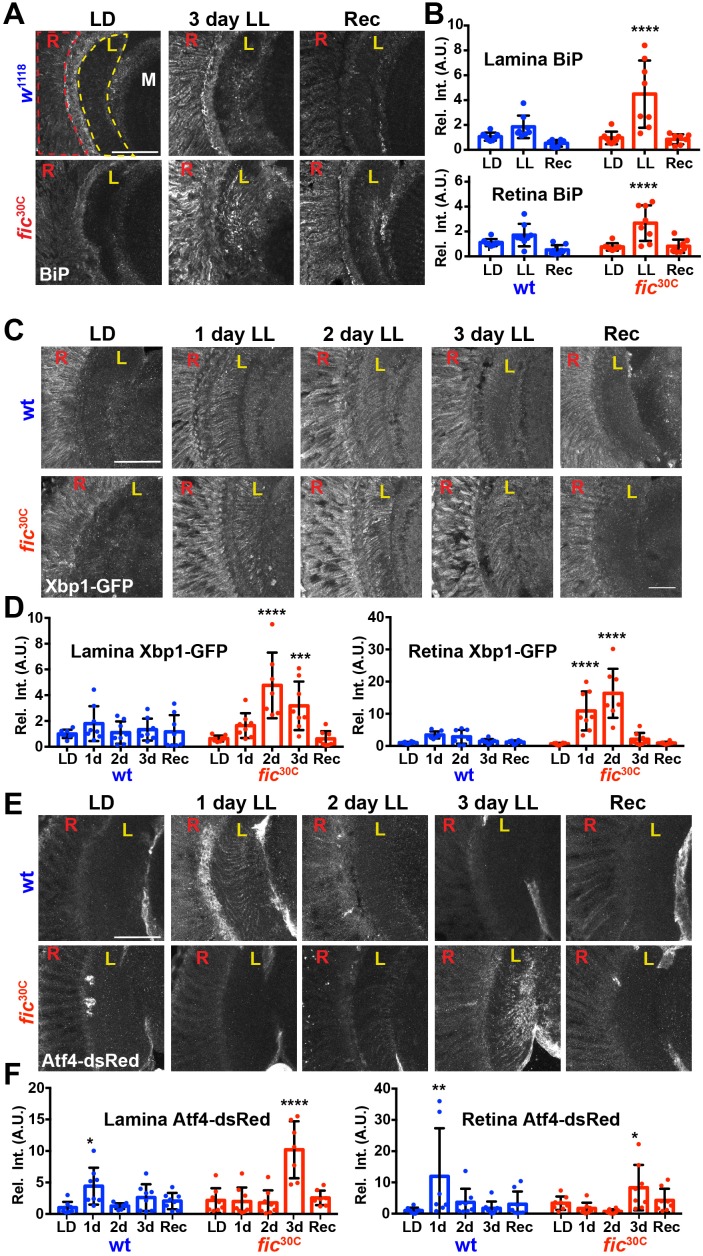
ER homeostasis is disturbed in fic mutants during prolonged light stimulation.(A) Representative images of BiP immunohistochemistry in sections of w1118 and fic30C flies following 3 days LD, LL or Recovery treatments. (B) Quantification of BiP fluorescence intensity, normalized to wild-type LD controls, in the lamina neuropil and retina from two independent experiments. (C) Representative images of a Xbp1-GFP splicing reporter in either a Fic wild-type or the null fic30C background following LD, 1 day LL, 2 day LL, 3 day LL, and Recovery conditions. (D) Quantification of GFP fluorescence intensity, normalized to wild-type LD controls, in the lamina neuropil and retina from two independent experiments. (E) Representative images of an Atf4-dsRed reporter in either a wild-type or fic30C background following LD, 1 day LL, 2 day LL, 3 day LL, and Recovery conditions. (F) Quantification of Atf4-dsRed intensity, normalized to wild-type LD controls, in the lamina neuropil and retina from two independent experiments. For all experiments, n = 8 flies per genotype/condition, with exceptions of outliers falling three standard deviations outside the mean. Bar graphs show means ± SD. For all experiments, significance is indicated for treatment compared to the LD condition for the corresponding genotype. ****p<0.0001; ***p<0.001; **p<0.01; *p<0.05. All scale bars: 50 µM.10.7554/eLife.38752.022Figure 5—source data 1.Relates to Figures 5B, D and F.Quantification of integrated intensity of BiP (5B), Xbp1-GFP (5D), and Atf4-DsRed (5F).